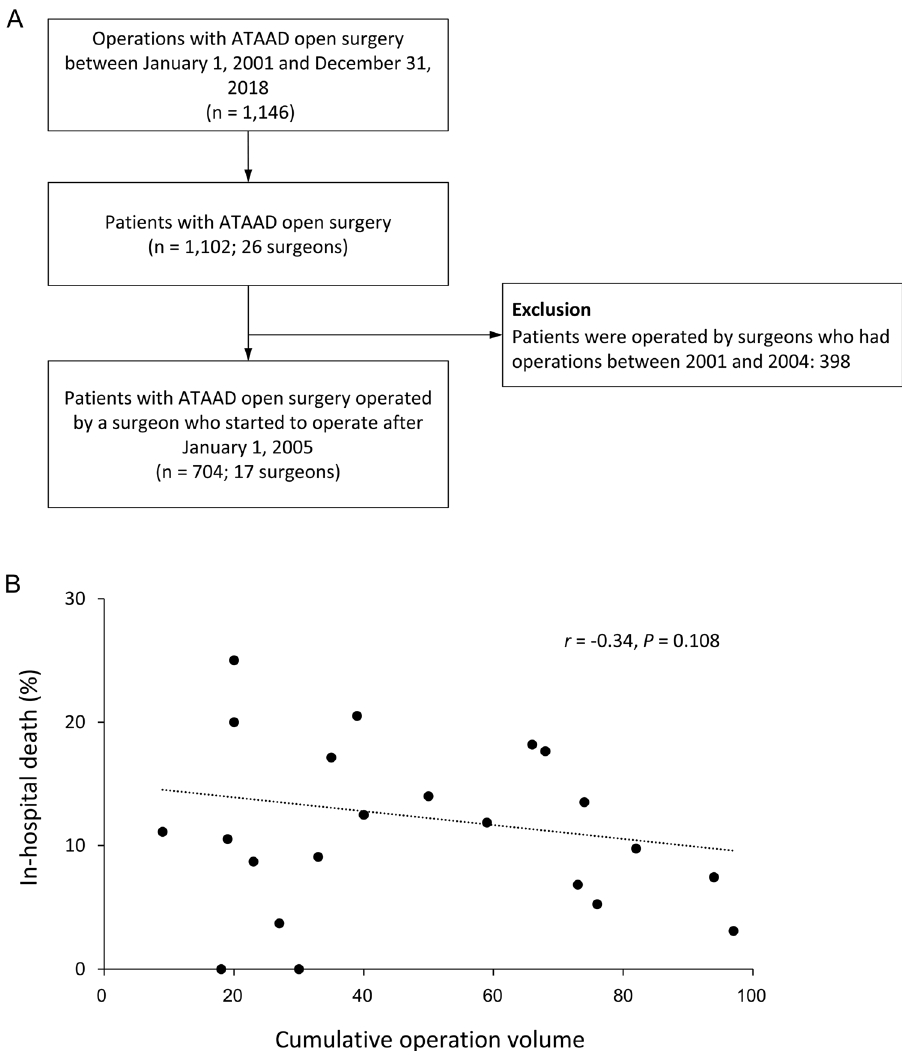
Figure 1. The flowchart for inclusion and exclusion of the study patients ( A ) and the relationship between cumulative operation volume of the surgeon (from 2001 to 2018) and the average in-hospital mortality rate of patients who are operated by the surgeon ( B ). Each point consists of all patients among the operations of the surgeon. Only those surgeons who conducted more than 10 operations are included in the plot. ATAAD, acute type A aortic